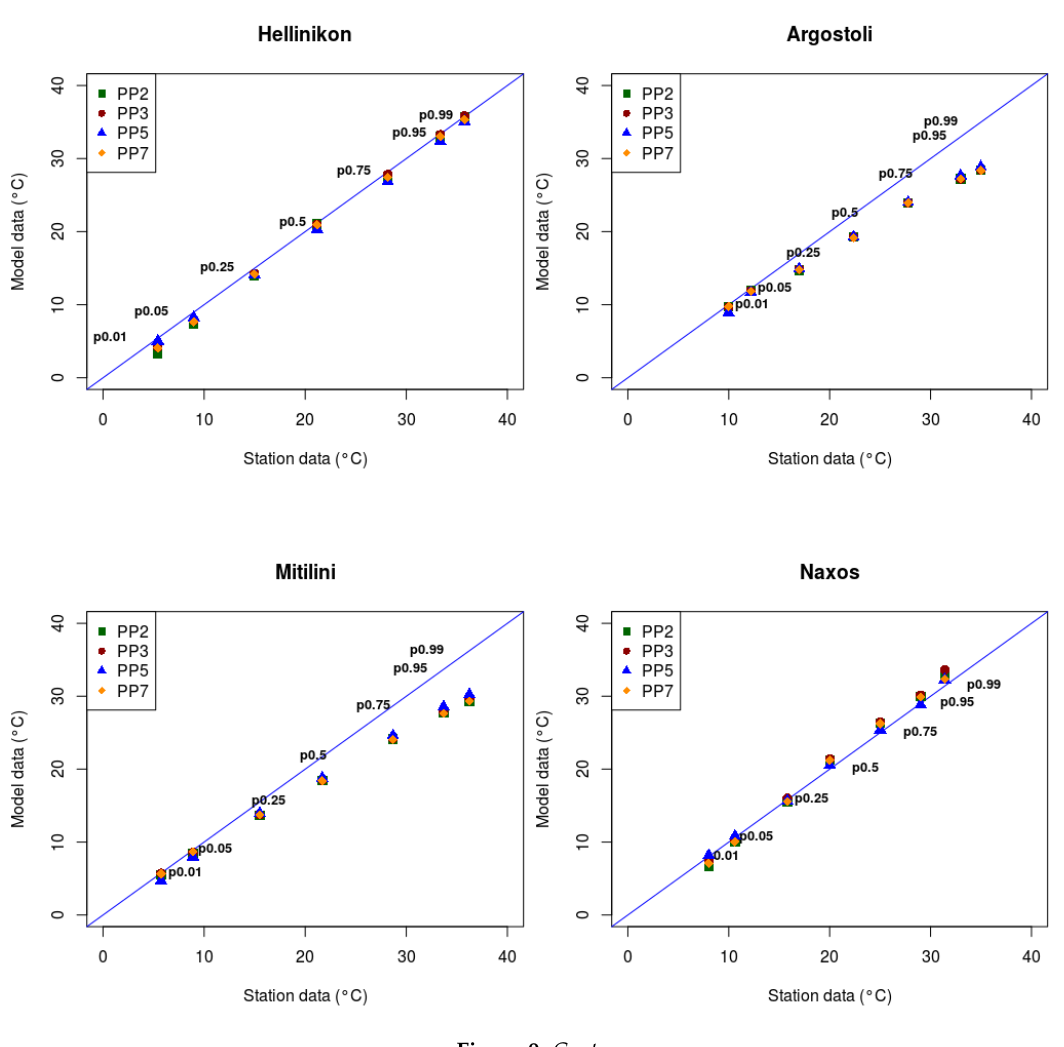
Figure 8. Comparison of the observed maximum temperatures by indicative weather stations, and the four simulated results in terms of probability distributions. The dashed line indicates the probability distribution of the